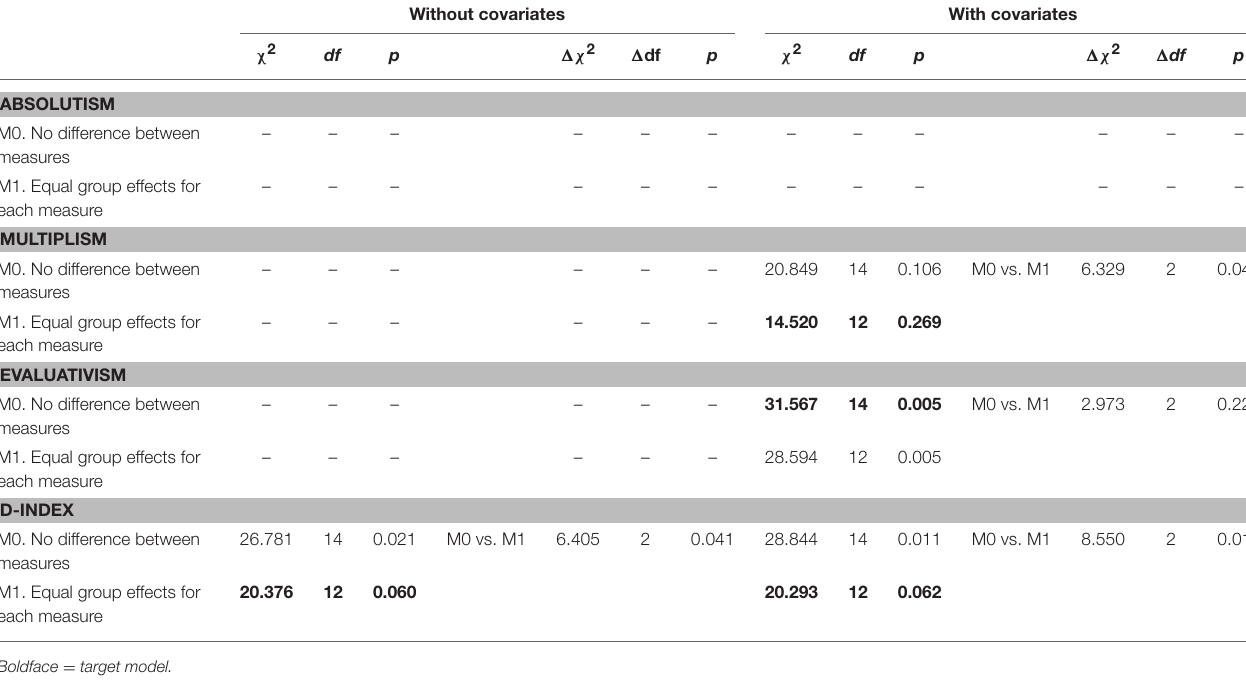
TABLE 7 | Fit indices and model difference tests for Hypothesis 2. Without covariates With covariates